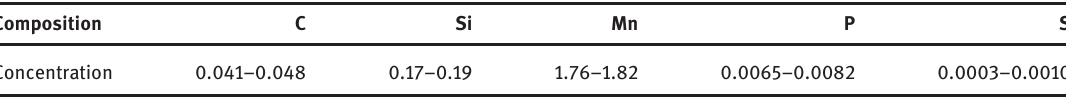
Table 4: Chemical composition of steel samples, mass%. Composition C Concentration